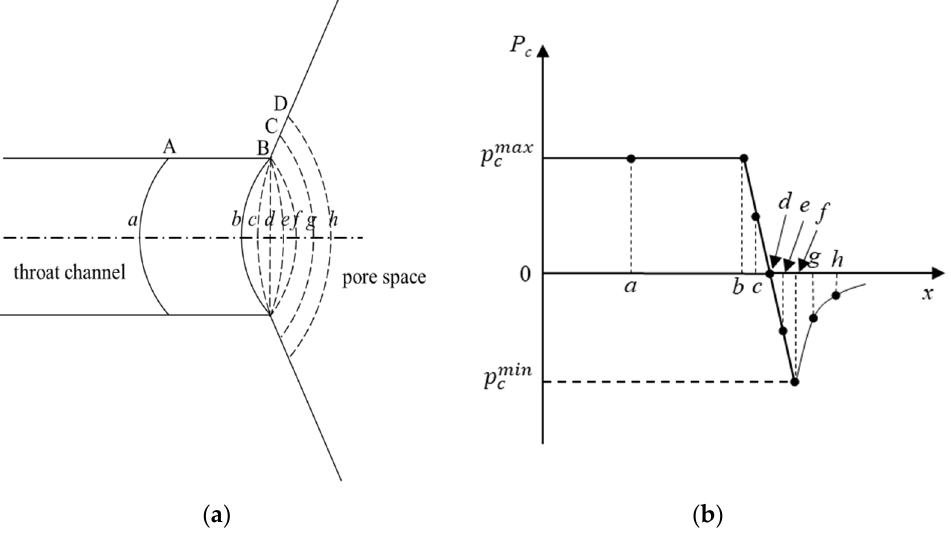
Figure 4. Schematic diagram of the oil–water interface morphology and capillary force variation along the axis: ( a ) the oil–water interface morphology at different locations; ( b ) the capillary force at different locations.